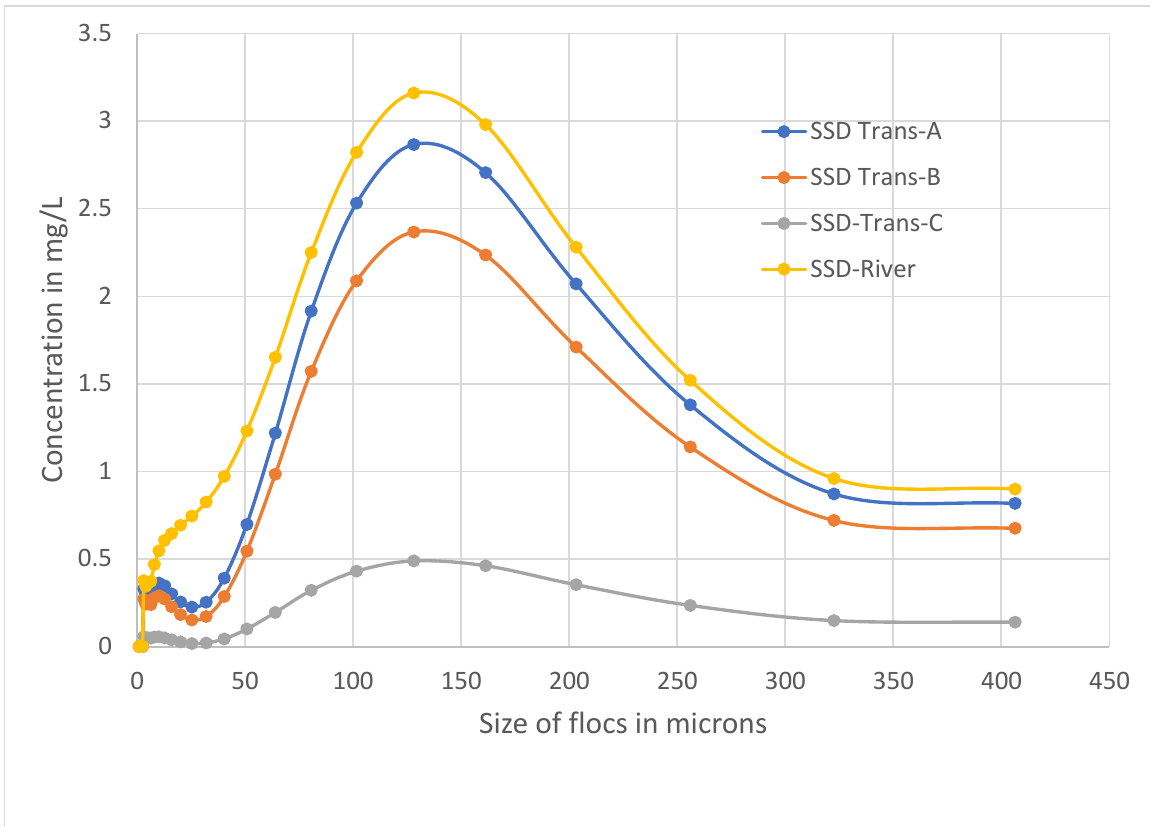
Figure 14. Effective particle size distributions of suspended sediment in river inflow and in the three transects across the Oldman Reservoir.